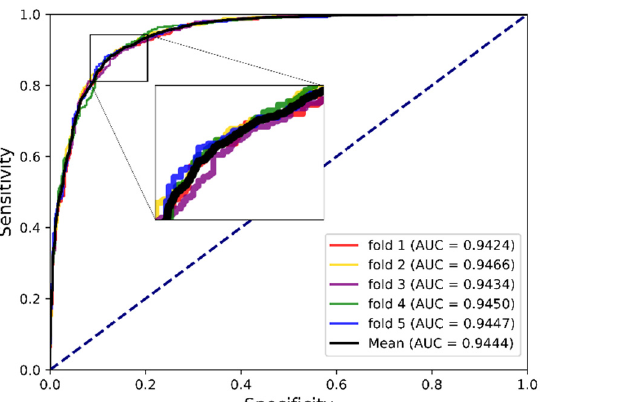
(b) Figure 6. (a)The ROC curves of the result on the SM2miR datasets. (b) The PR curves of the result on the SM2miR datasets. 3.3. Comparison with Other Embedding Methods The topological feature generated by SDNE is an important part of the MFIDMA model. To demonstrate the efficiency of SDNE, we conducted an experiment to compare SDNE and three popular graph embedding methods in different dimensions. Using the same approach of constructing topological features, three other state-of-the-art graph em- bedding methods (i.e., LINE, Node2vec [71] and Laplacian Eigenmaps (LE) [72]) were uti- lized to extract the potential graph relationship information and were compared with the SDNE algorithm. The LINE method considered two kinds of proximities, the 1st-order and 2nd-order proximities, and a leverage asynchronous stochastic gradient algorithm (ASGD) [73] to integrate the two kinds of proximities. The Node2vec method is an im- proved on the DeepWalk method. It uses biased random walks to sample on the network. Laplacian Eigenmaps is a matrix factorization-based method, which can keep two nodes